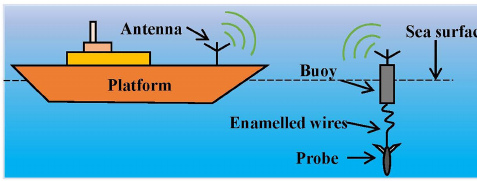
Figure 1. Schematic of expendable current profiler (XCP) opera-